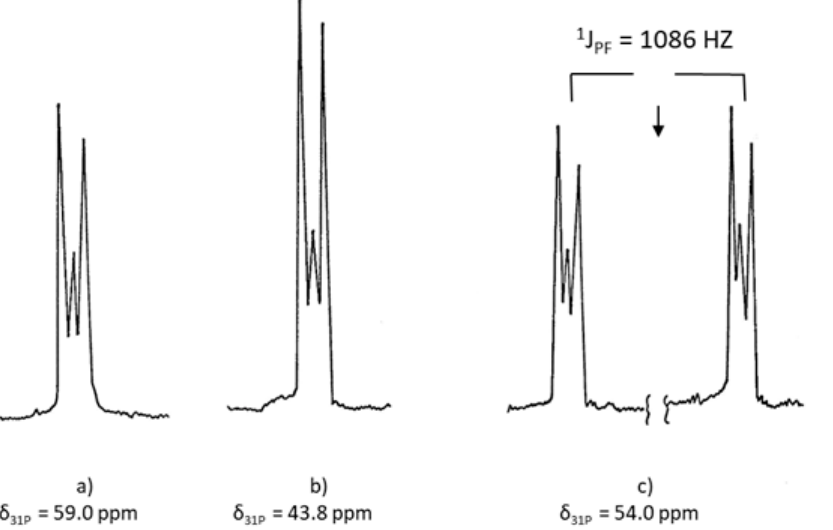
Figure 4. 31 P-NMR spectra of diastereomeric 2-halogeno-4-methyl-1,3,2-dioxaphosphorinan- 2- thiones 6 obtained with a Jeol-C60H-NMR spectrometer; ( a ) trans - 6 ( Cl ) ( b ) trans - 6 ( Br ) and ( c ) cis - 6 ( F ).